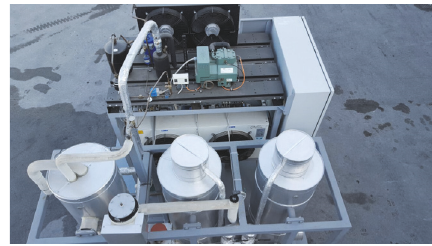
Figure 5: View of the plant subsystem for noncondensable separa-